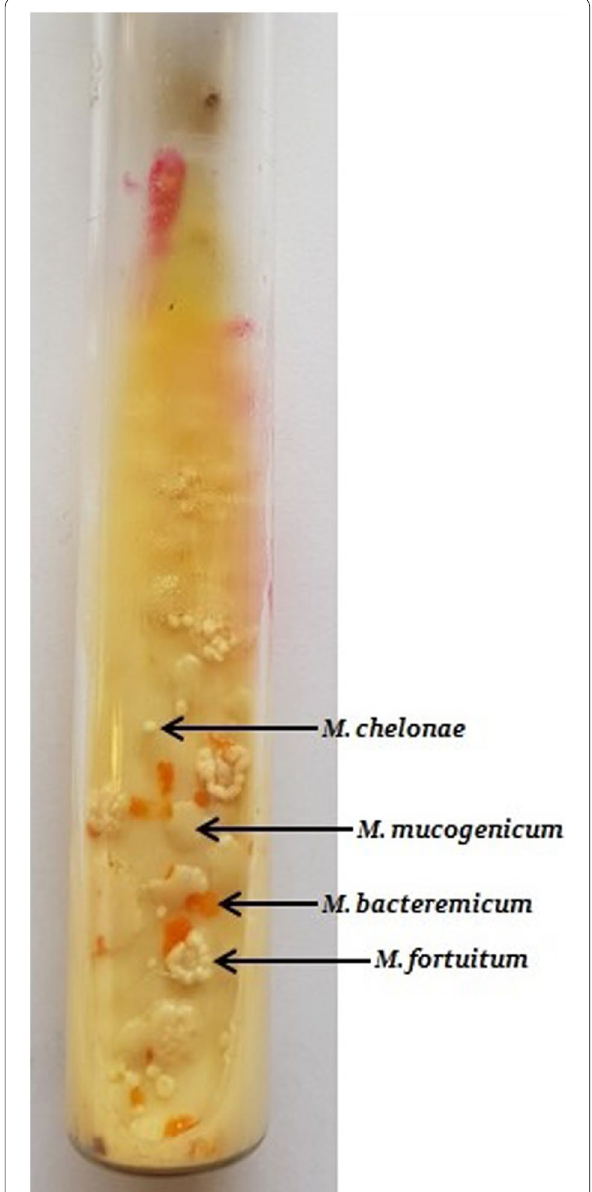
Fig. 1 Showing four colonies of nontuberculous mycobacteria over Lowenstein-Jensen media